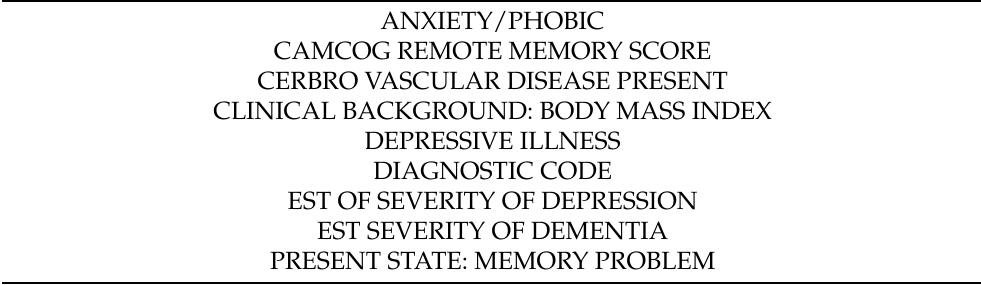
Table 4. Important Feature list for identifying misdiagnosed patients other than MMSE related